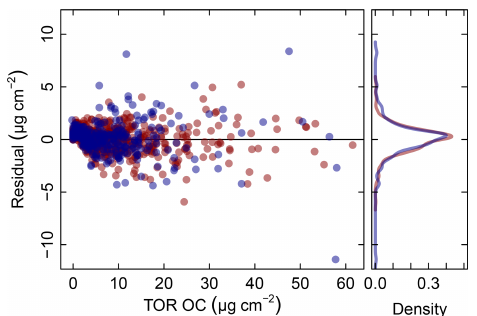
Figure 5. Residuals (red symbols) and prediction errors (blue sym- bols) from 2011 IMPROVE OC (baseline corrected, base case) pre- dictions. The corresponding kernel density estimate of the distribu- tion is shown on the